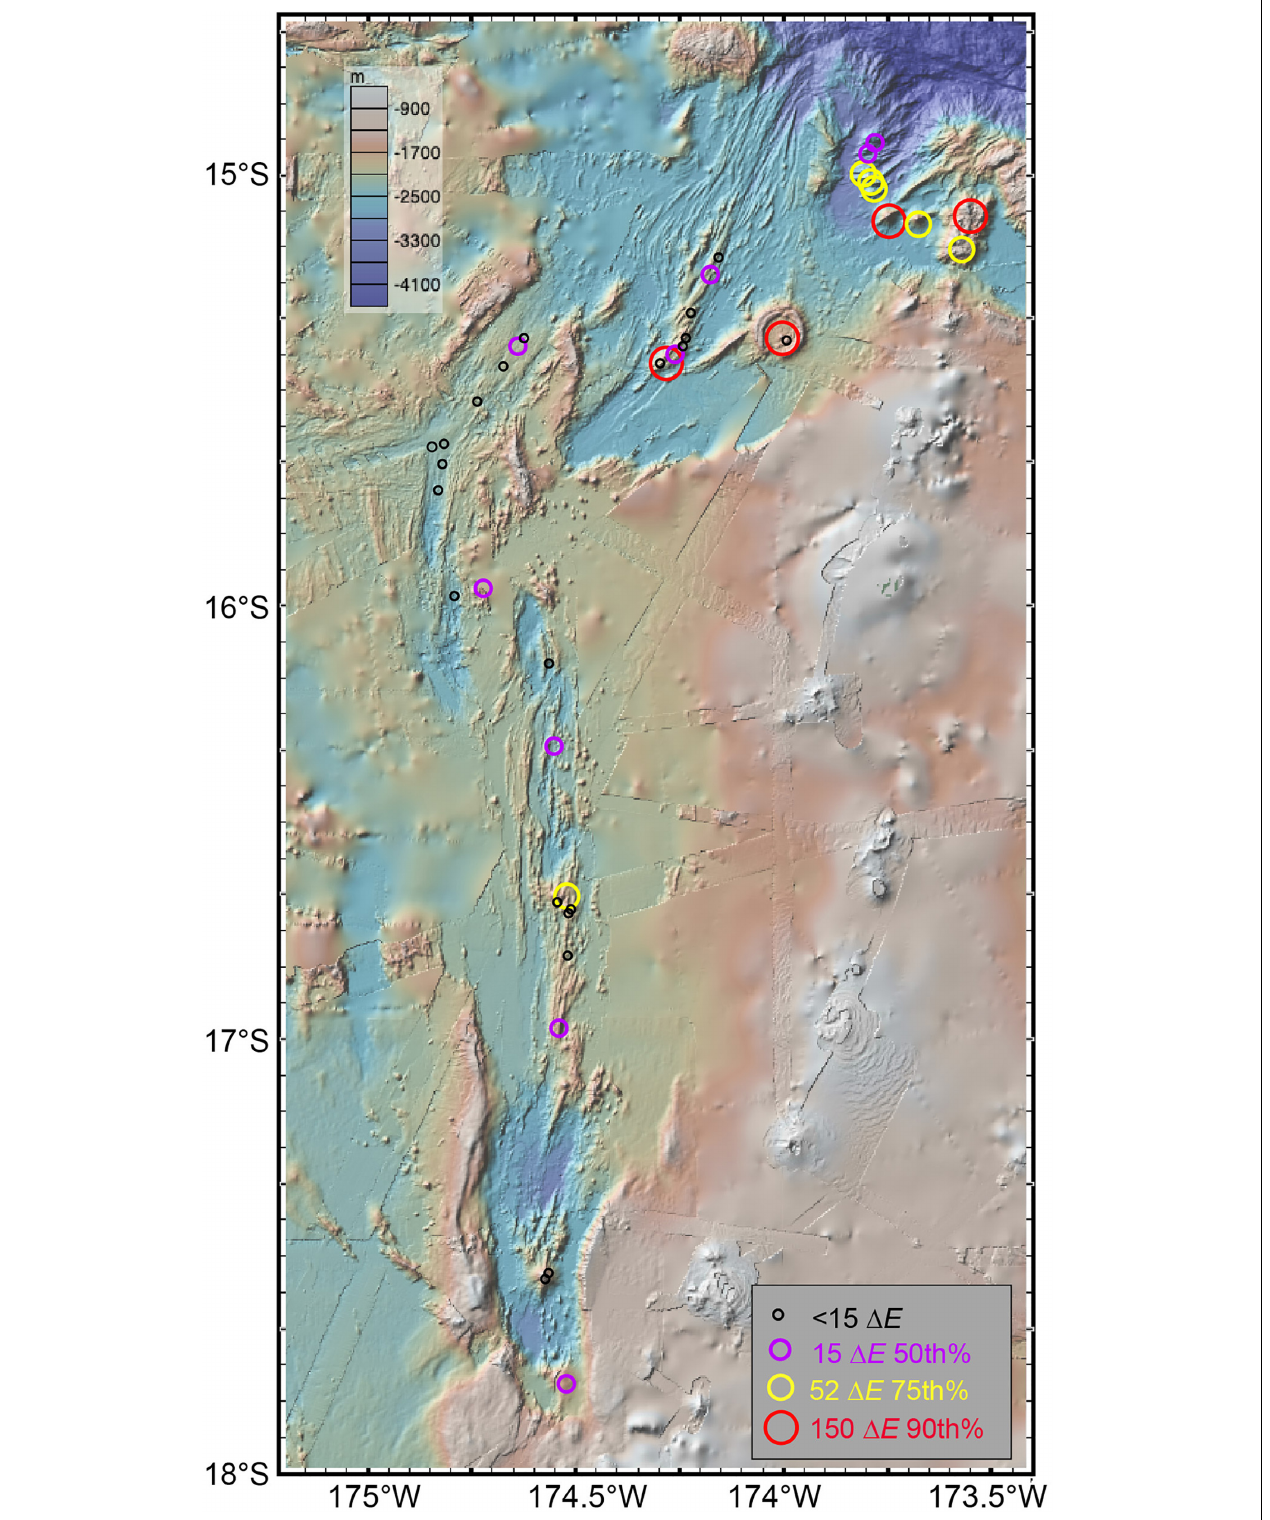
FIGURE 7 | Distribution of maximum (cid:49) E (mV)at each site: ≥ 90th percentile (red), ≥ 70th–90th percentile (yellow), ≥ 50th–70th percentile (lavender), < 50th percentile (black). Values given in Tables 1 , 2 . Figure made with GeoMapApp (www.geomapapp.org).